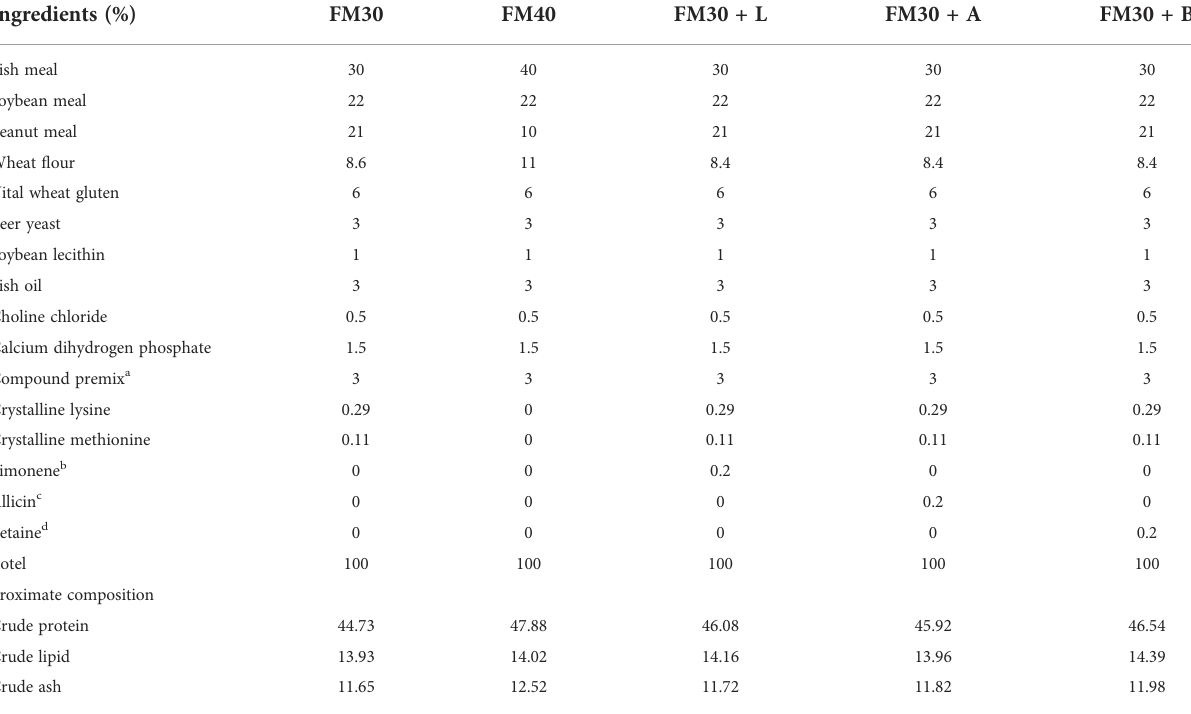
TABLE 1 Composition and nutrient levels of experimental diets for M. salmoides (dry-weight basis). Ingredients